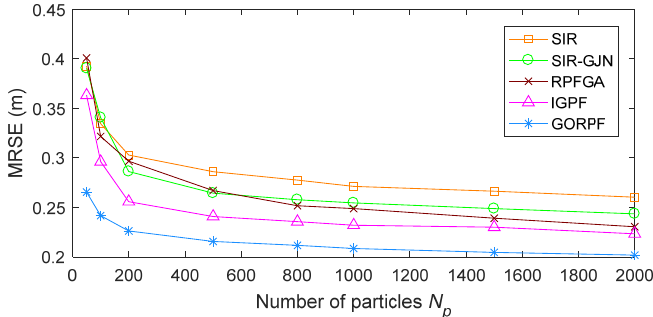
Figure 8. The comparison of MRSE with different numbers of particles.